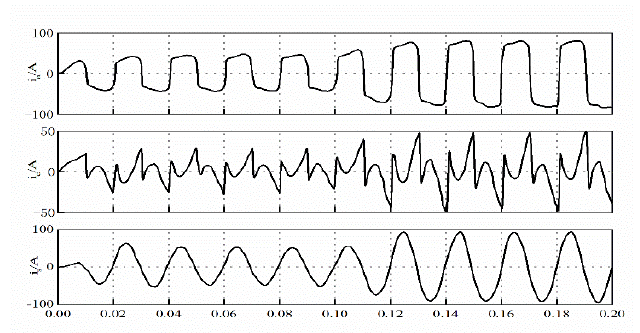
Figure 13. Composite control of each current waveform.